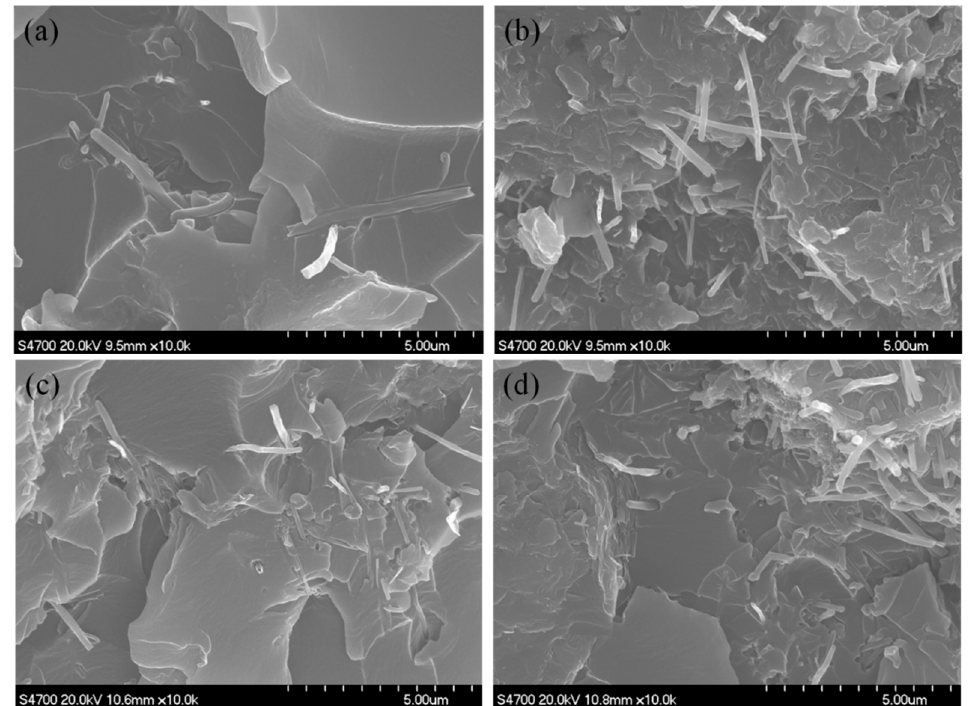
Figure 3. SEM micrographs of the fractured surface of the epoxy composites with AMGNS-MWCNT mixture contents of ( a ) 0.5 wt%, ( b ) 1.0 wt%, ( c ) 2.0 wt%, and ( d ) 3.0 wt%. (Supplementary Materials